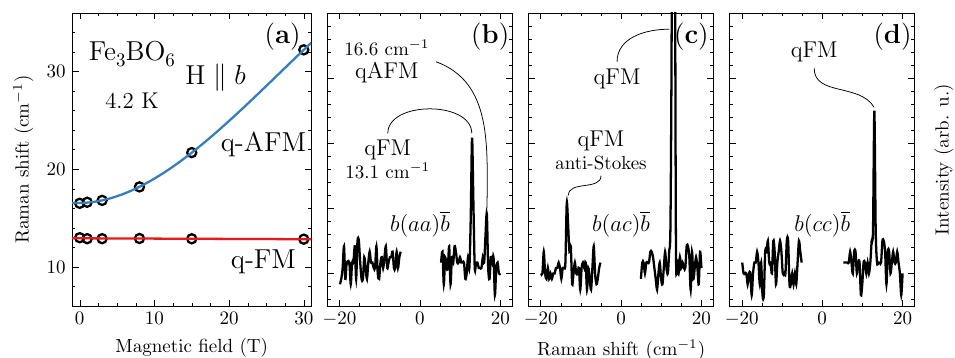
Figure 5. ( a ) Magnetic field dependence of the quasi-ferromagnetic (qFM) and quasi-antiferromagnetic (qAFM) magnon modes in magnetic field parallel to the crystal b axis. ( b – d ) qFM and qAFM modes at different polarizations in low-frequency regions in both Stokes and anti-Stokes